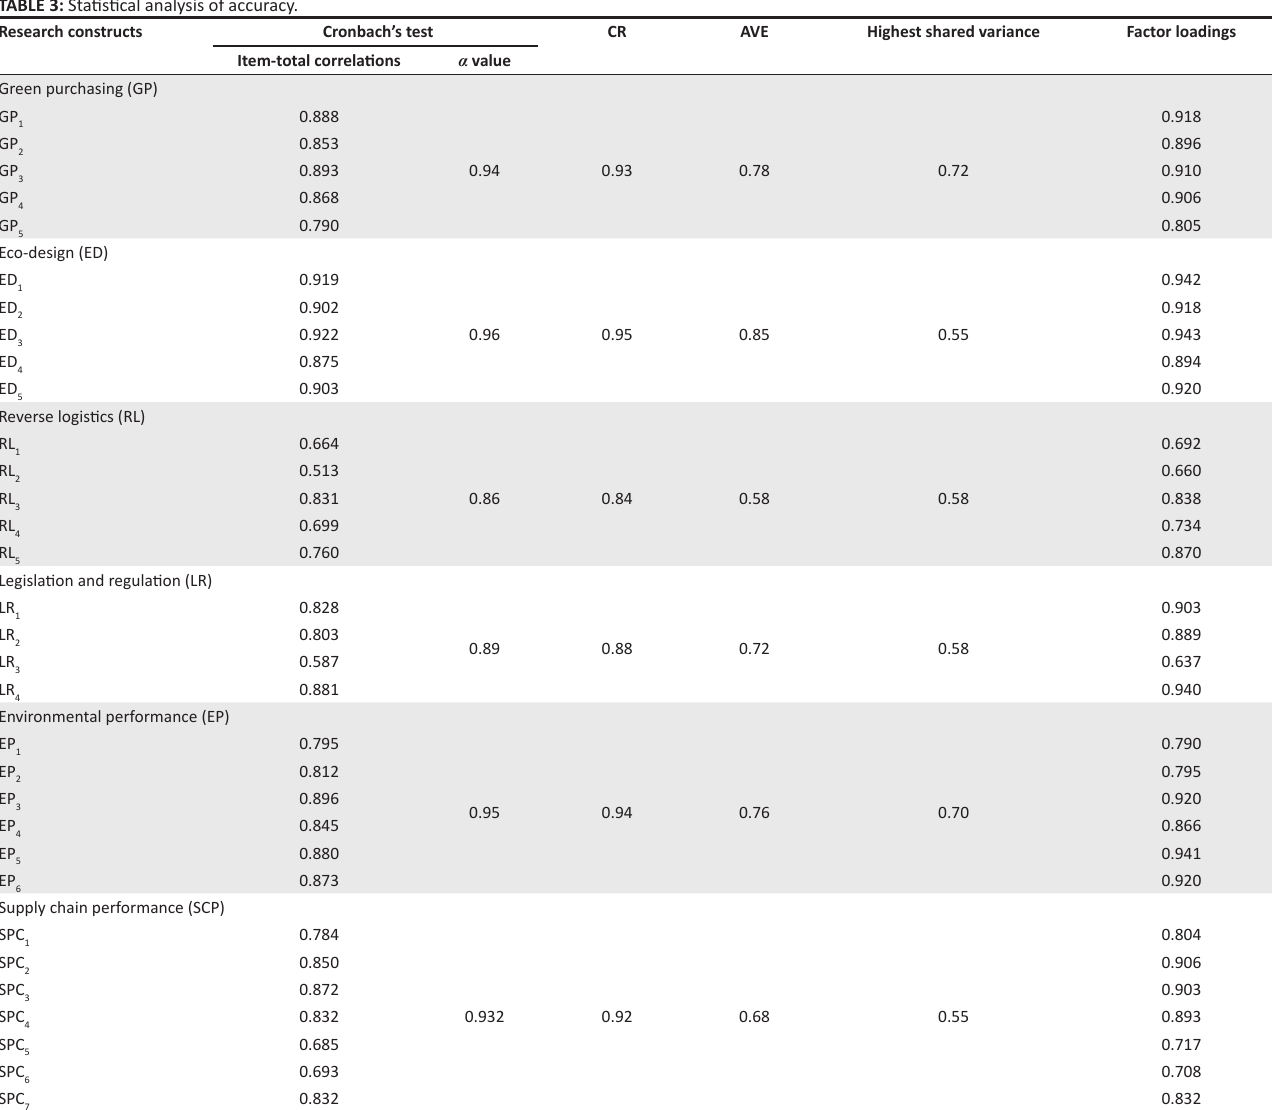
TABLE 3: Statistical analysis of accuracy. Research constructs